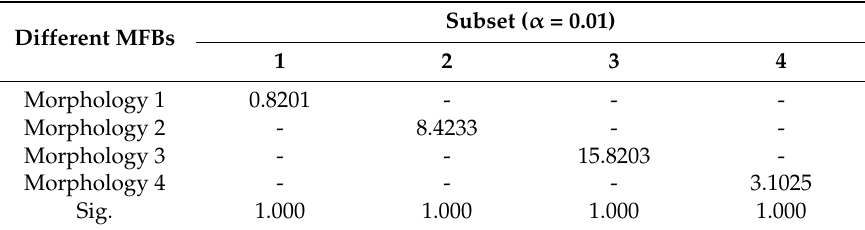
Table 5. Means comparison of unreduced pollen yield between any two different MFBs by S-N-K comparison analysis (Significance level =